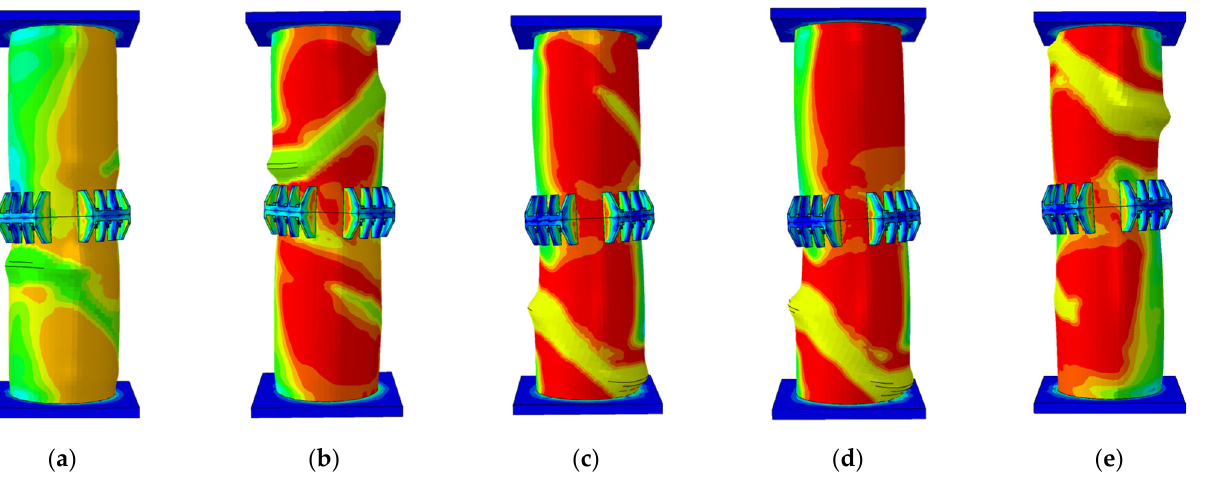
Figure 24. Simulated failure modes of BWCFST short column specimens with interfacial gap of different θ : ( a ) θ = 0 ◦ ; ( b ) θ = 90 ◦ ; ( c ) θ = 180 ◦ ; ( d ) θ = 270 ◦ ; ( e ) θ = 360 ◦ . The cross-section at the middle height of the BWCFST short columns is selected for the analysis of interaction stress ( p ) between the steel tube and core concrete at the peak strength. The distributions of longitudinal stress (S33) of core concrete and the p at the interface of core concrete of BWCFST short columns with different θ are presented in Figure 25. For a continuous CFST short column [8], the highest value of S33 is displayed at the center of the cross-section, and the value of S33 is smaller at the position with a larger diameter. In addition, the S33 exhibits a constant distribution due to the same p along the circumference. However, the S33 distribution of BWCFST short columns shows the difference with that of continuous CFST short column, as shown in Figure 25a. The highest value of S33 occurs in areas without the flange support and with the highest p . The values of p near the flange edge tend to be 0, and the column shows constant distribution near the flange. It can be seen that the value of S33 at the center is smaller, unlike that of the continuous CFST short column. This is owing to that the existence of the flanges changes the confinement region, and the confinement path bypasses the center. However, the high values of S33 are presented in the other areas except the center area and the areas near the flange edge. For the BWCFST short columns with interfacial gap, the gaps did not change the characteristics of the S33 distribution, but the confinement path. The distribution of the BWCFST short column with θ of 360 ◦ has agreement with that of the normal BWCFST short column, as shown in Figure 25e. But lower p is found in the BWCFST short column with θ of 360 ◦ due to the less confinement from steel tube. In general, the existence of the interfacial gaps almost has no influence on the confinement effect and the distribution of S33 of BWCFST short columns at the peak strength in the simulations. Therefore, the peak strength of BWCFST short columns with different θ are basically the same, and the bearing capacity is different only at the post-peak